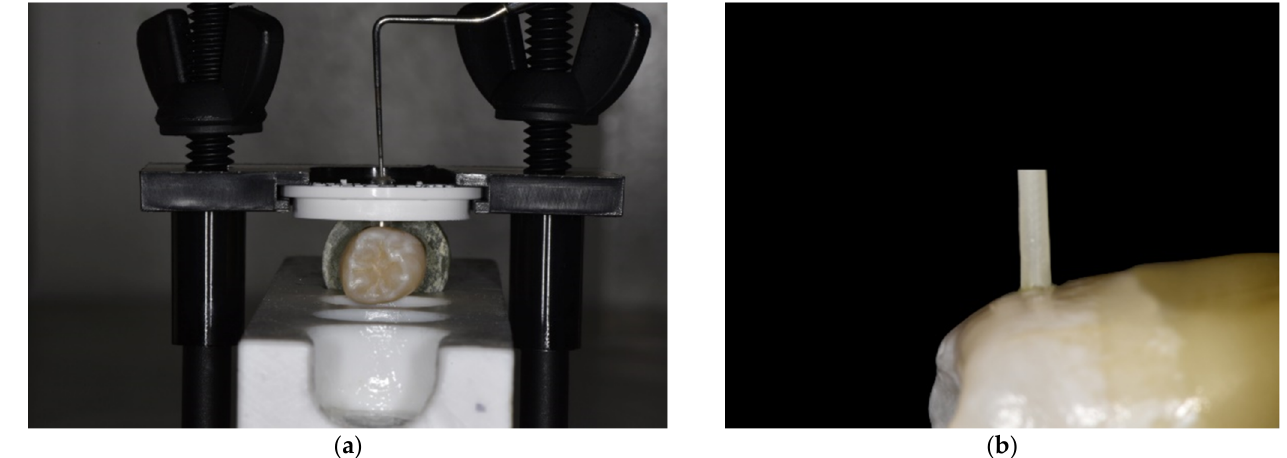
Figure 1. Photographs of the experimental setup ( a ) and of one specimen ( b ).